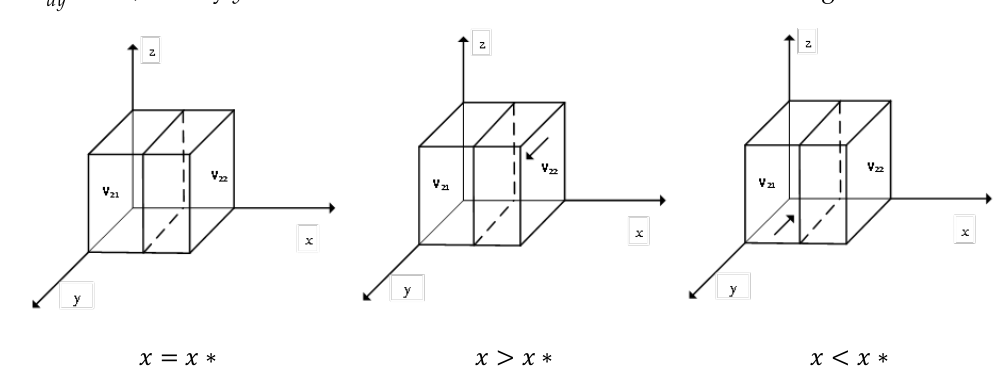
Figure 2. Evolutionary phase diagram of alliance stabilization